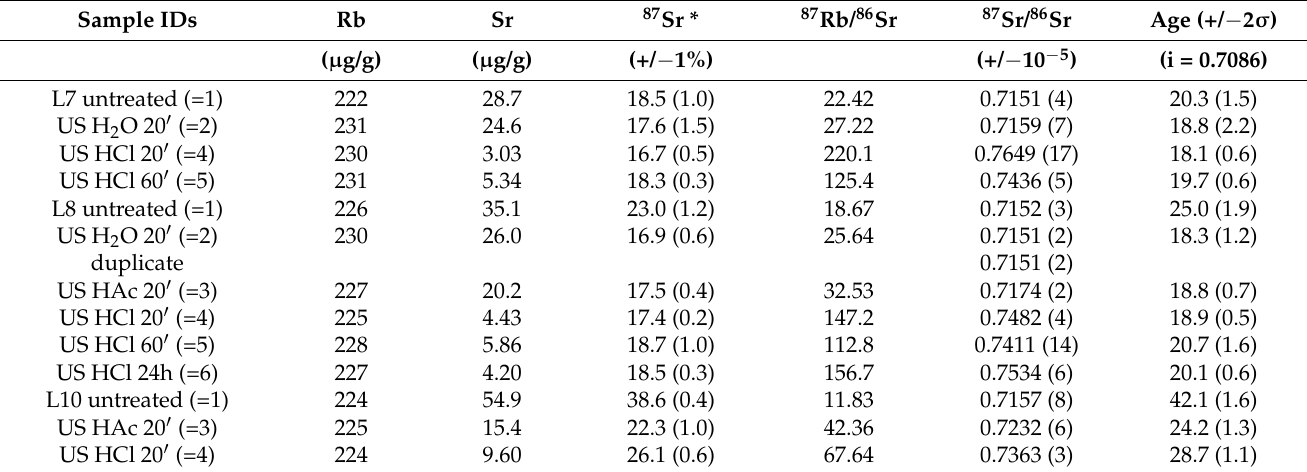
Table 4. Report of the Rb–Sr data of the untreated and leached glauconite pellets by Pasteels et al. [6]). The * stands for radiogenic and the i for initial ratio that corresponds to the seawater ratio at the syn-deposition time of glauconite